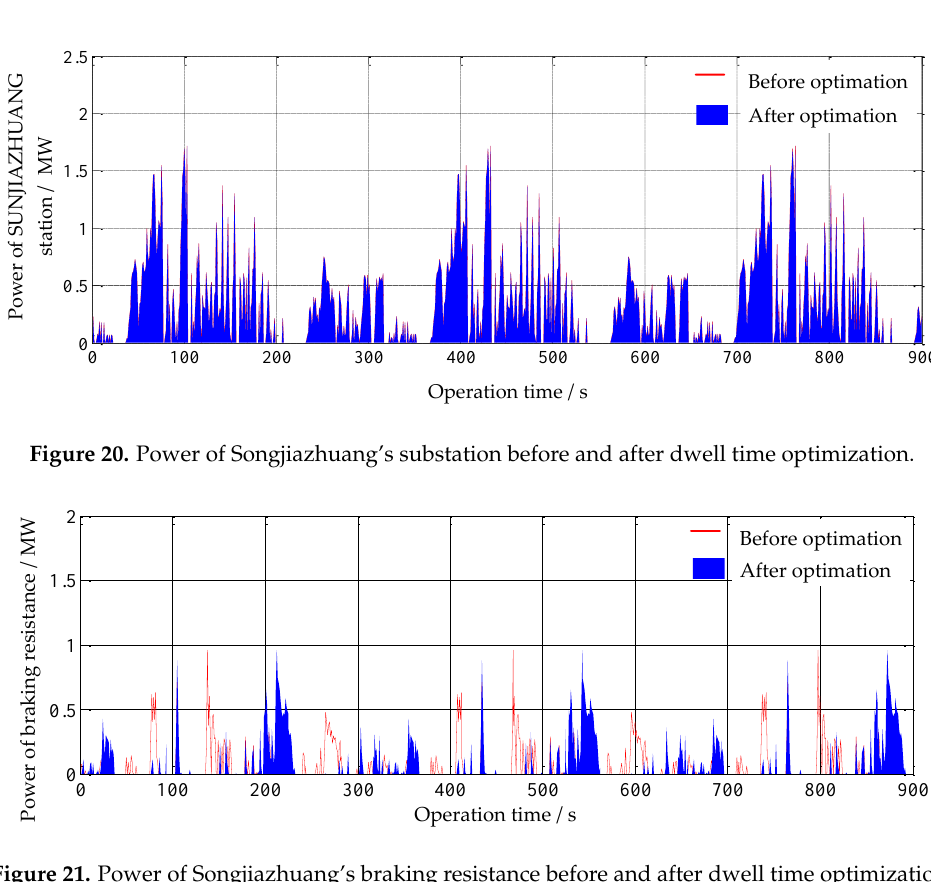
Figure 21. Power of Songjiazhuang’s braking resistance before and after dwell time optimization.